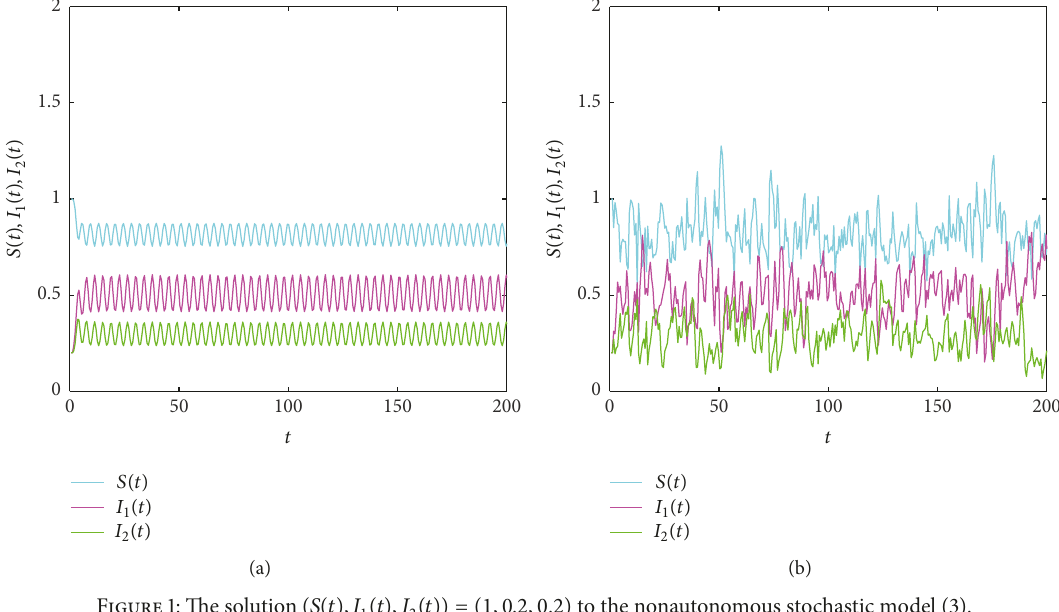
Figure 1: The solution (𝑆(𝑡),𝐼 1 (𝑡),𝐼 2 (𝑡)) = (1,0.2, 0.2) to the nonautonomous stochastic model (3).